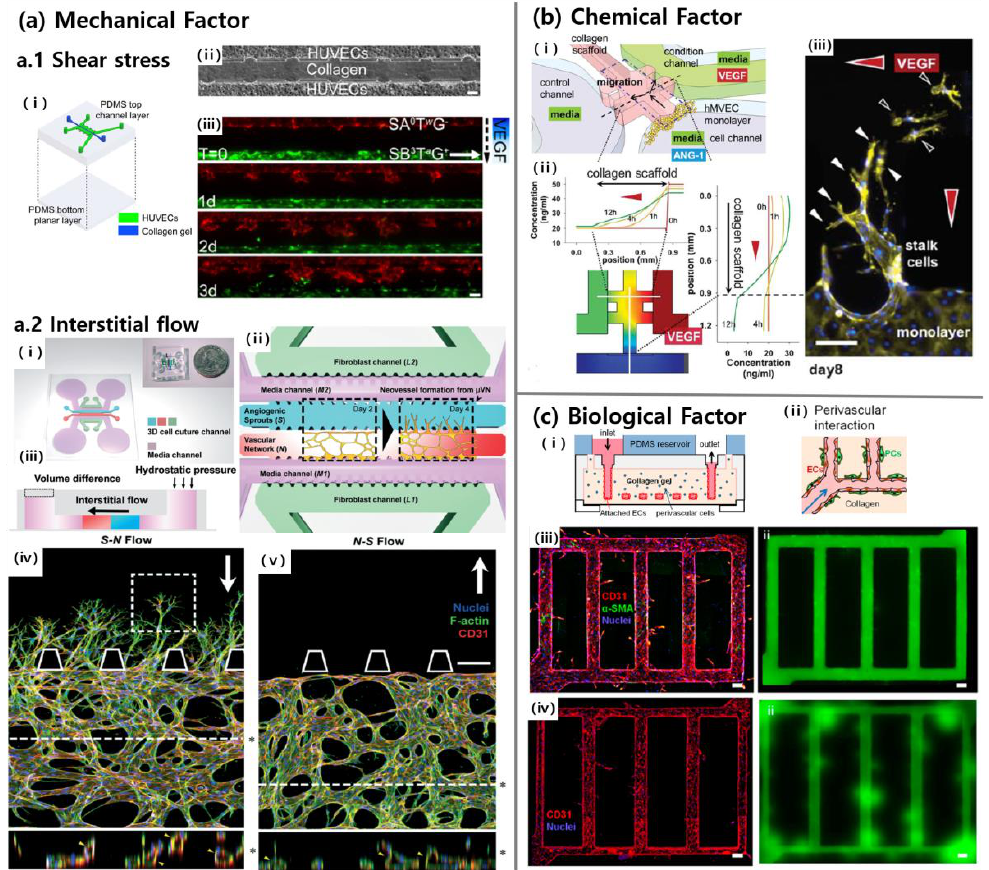
Figure 2. Three major factors (mechanical, chemical, and biological factors) in vessel formation on a chip. ( a.1 ) Fluid flow was given by syringe pumps that were connected to reservoirs of the chip (i), which had one channel for collagen and two channels for human umbilical vein endothelial cells (HUVECs) (ii). Shear stress inhibited sprouting in the presence of interstitial flow and vascular endothelial growth factor (VEGF) gradient (iii) [12]. Scale bars 100 μm. ( a.2 ) Angiogenic sprouting from the vascular network (i–ii) was observed in the presence of interstitial flow (iii). Sprouting was more active when the interstitial flow acts on sprouting in reverse direction (iv), than forward direction (v) [45]. Scale bar 200 μm. ( b ) The direction of sprouting could be guided along spatial VEGF gradient (iii) by forming two orthogonal gradient profiles on the gel region (i–ii) [21]. Scale bars 100 μm. ( c ) HUVECs were seeded on the hollow microchannels in the pericyte-embedded collagen gel (i) to generate stable vascular structures through heterotypic cell–cell interactions (ii). Pericytes (α-SMA, green) enclosed endothelial wall (CD31, red) and contributed to structural stability (iii) confirmed by perfusing of fluorescent microbeads (green). A number of leakages could be observed when only HUVECs were seeded (iv) [56]. Scale bars 100μm. Reproduced with permission.